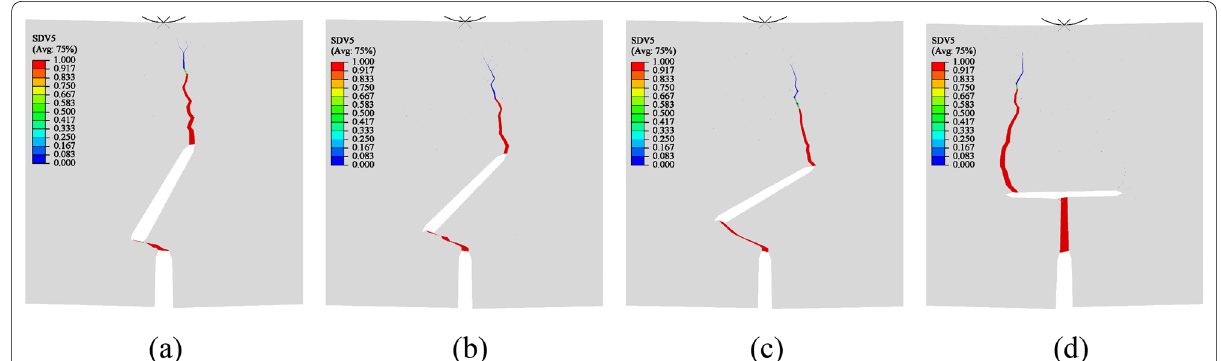
Fig. 14 SDV5 nephograms of the models with ( a ) θ